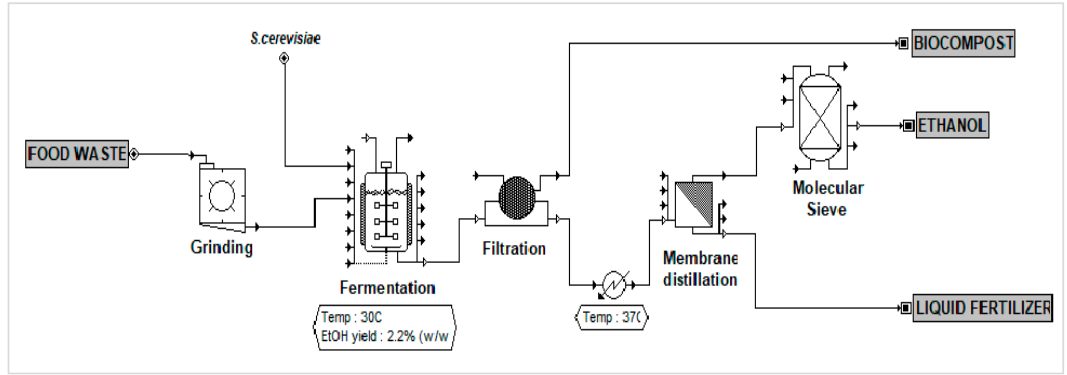
Figure 3. Process flow diagram of FW fermentation with membrane distillation separation process.